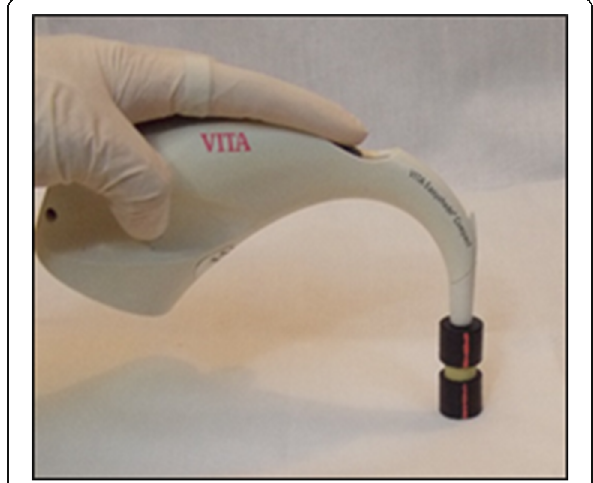
Fig. 3 Spectrophotometer engaged in the mold ready for color